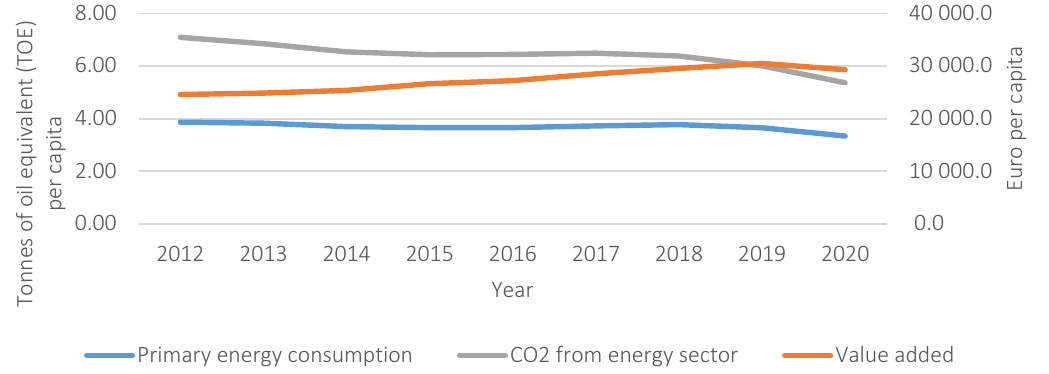
Figure 9. Energy consumption, GDP growth, and CO2 emissions from the energy sector, average